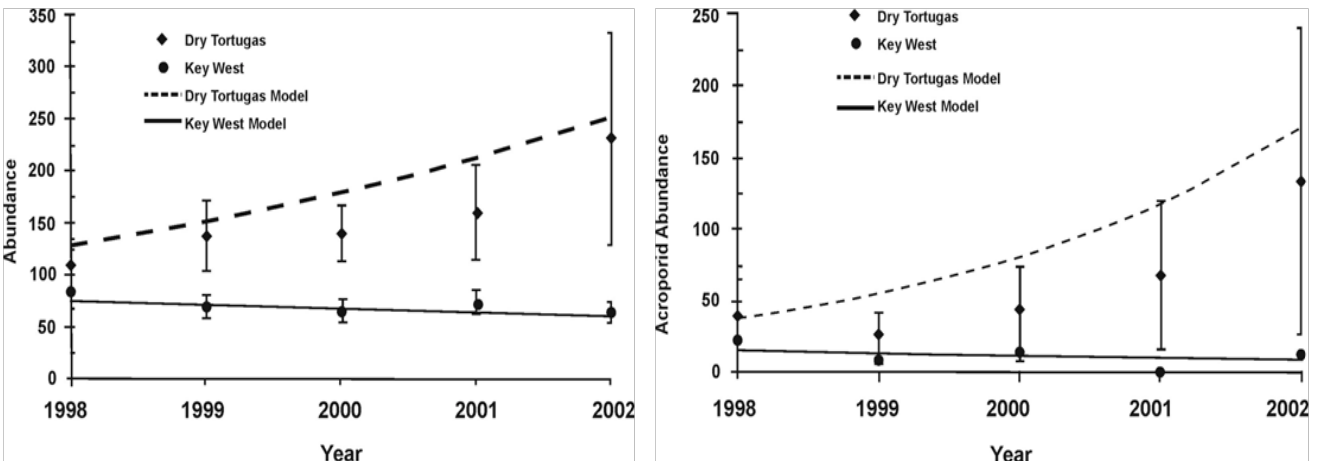
Figure 5. Poisson regression models of temporal changes in abundance at survey periods between summer 1998 and summer 2002 in reef areas near Dry Tortugas (DT) and Key West (KW): ( a ) total mean abundance (±SE); ( b ) mean acroporid abundance